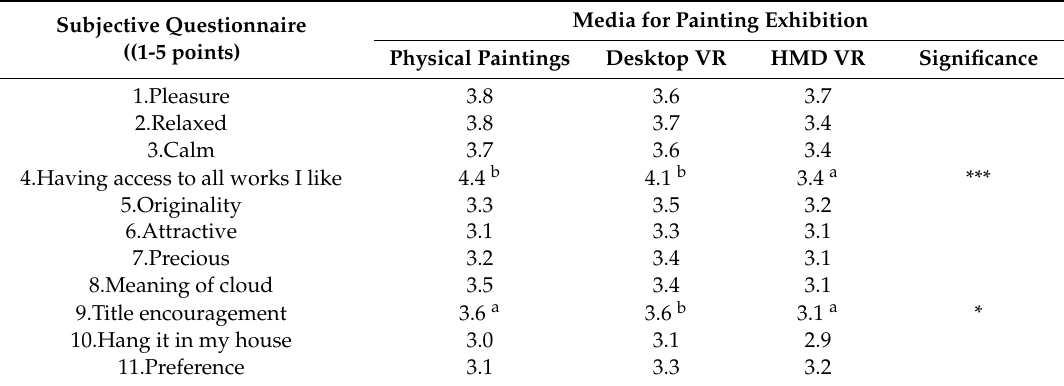
Table 1. Results of descriptive statistics and ANOVA